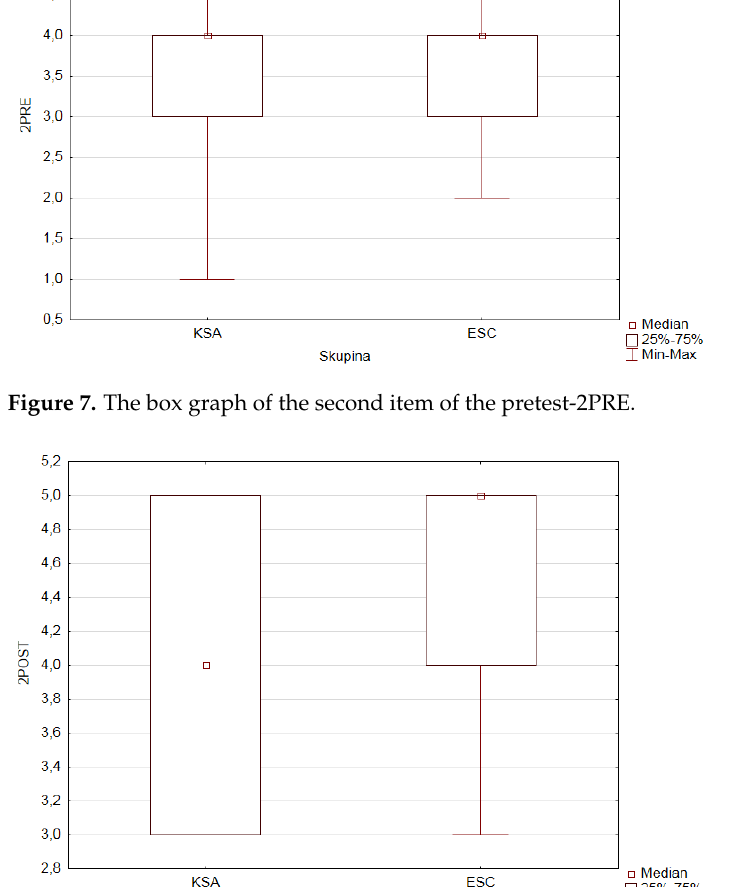
Figure 8. The box graph of the second item of the posttest - 2POST.